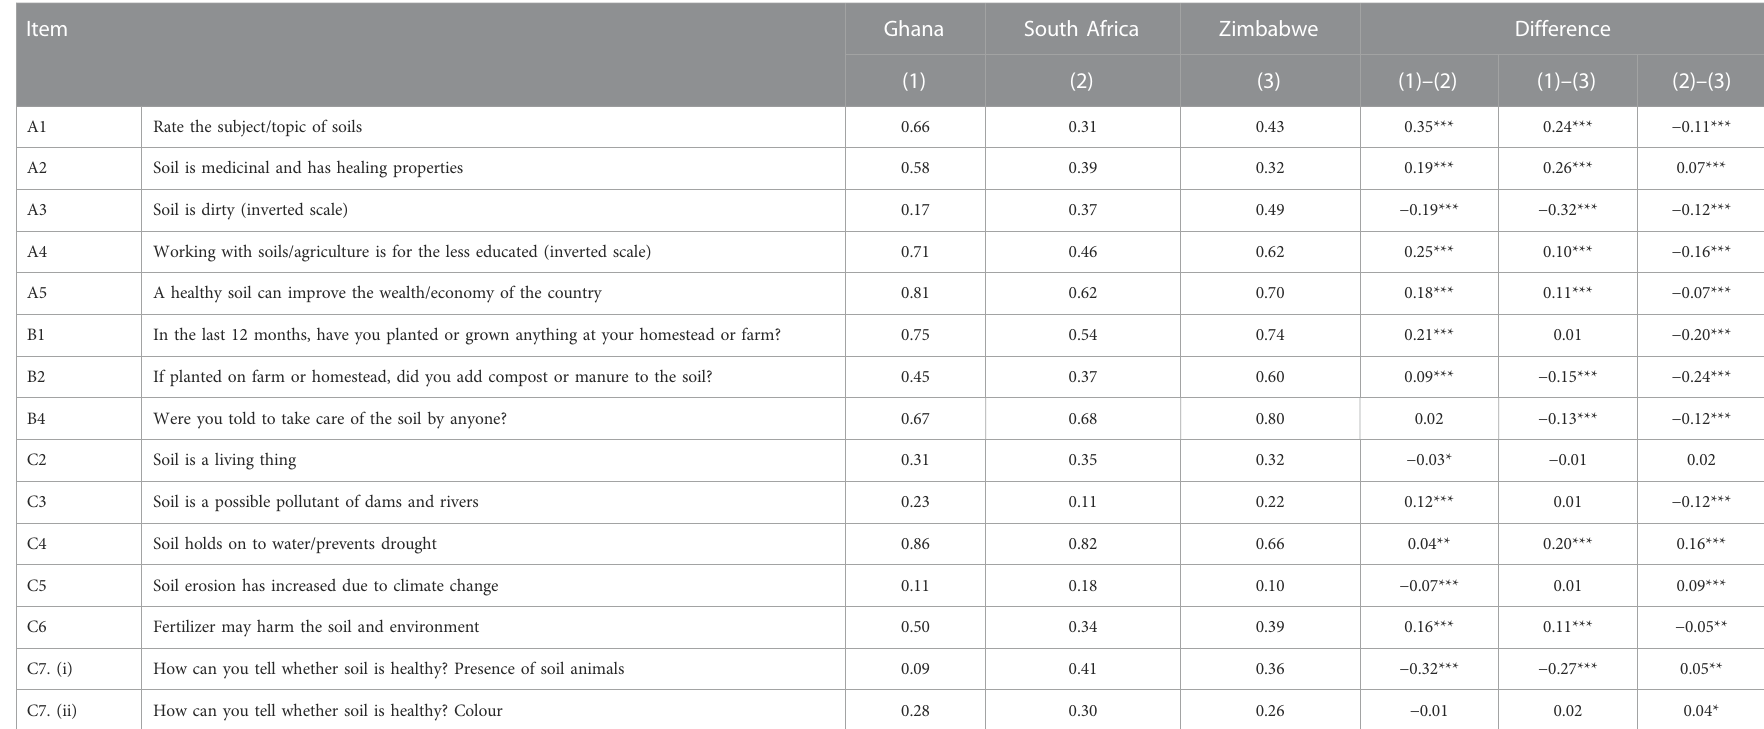
TABLE 3 Abridged results from selected questions from the ABC of Soil survey (from Johnson et al., 2020).